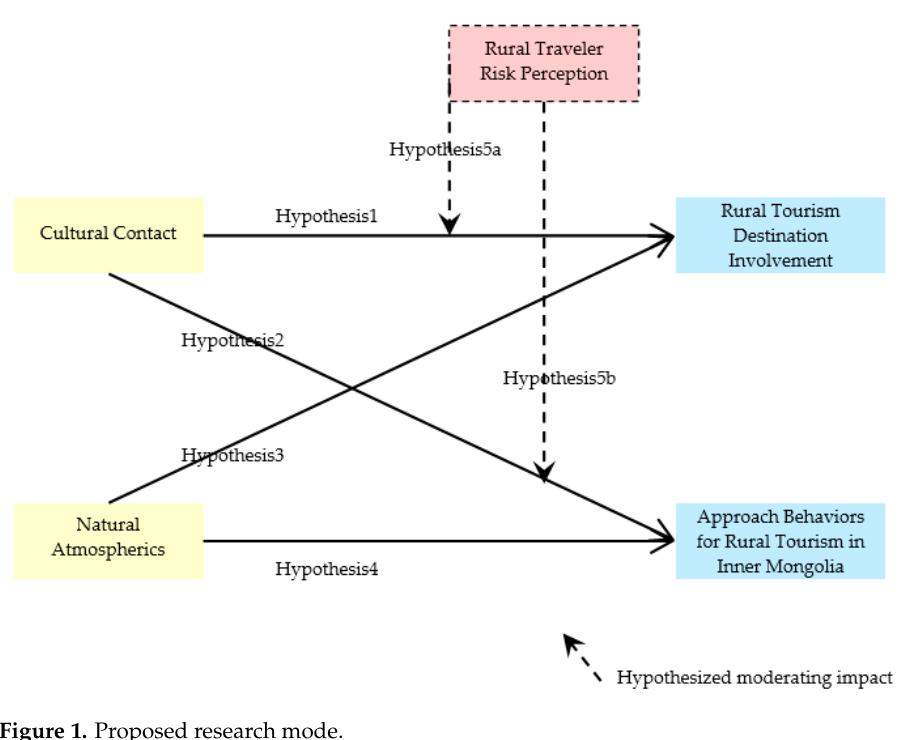
Figure 1. Proposed research mode.